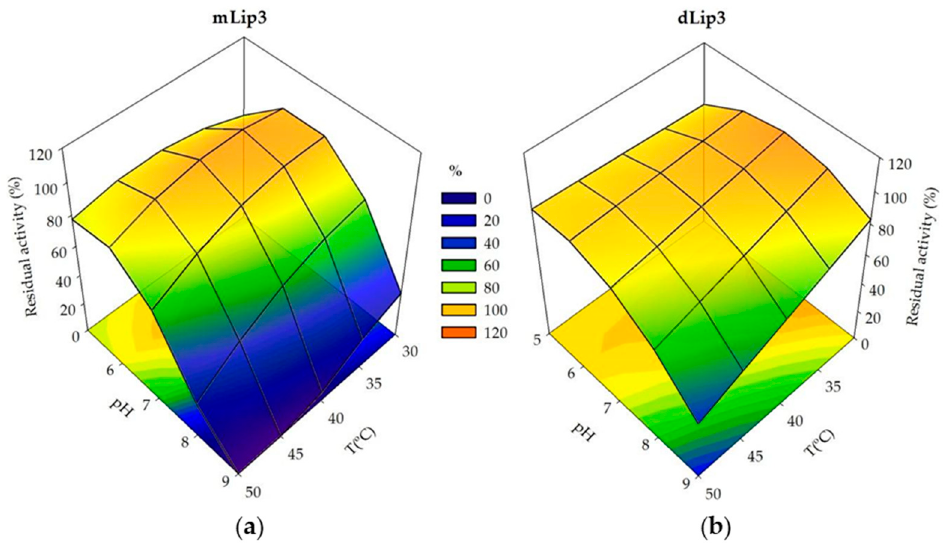
Table 5. Optima pH and temperature values for mLip3 and dLip3 stability.